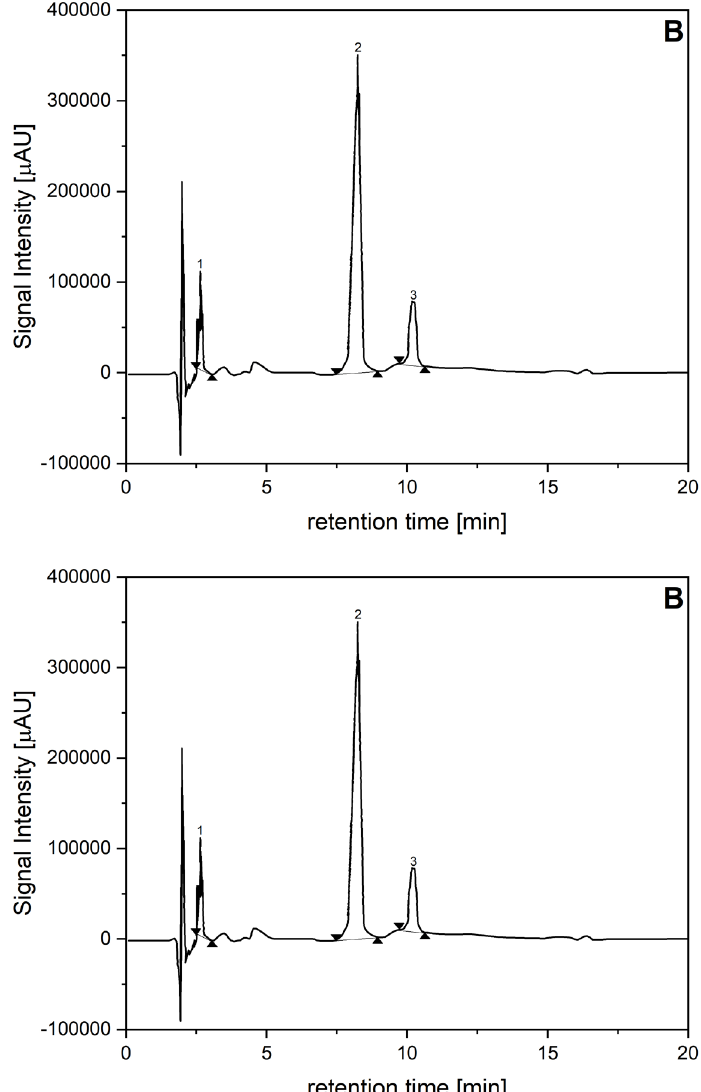
FIGURE 2 - Chromatograms showing: A. Physiologic solution of NaCl 0.9%; B. Analgesic solution of 1. CLO HCl 4.0 µg/mL; 2. ROP HCl 100.0 µg/mL and 3. FENT CIT 30.0